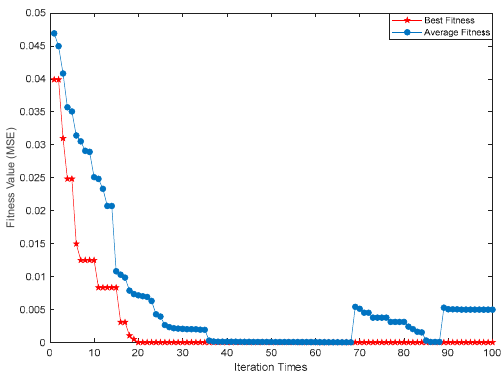
Figure 5. Fitness curve of CGTSSA screening health factors.